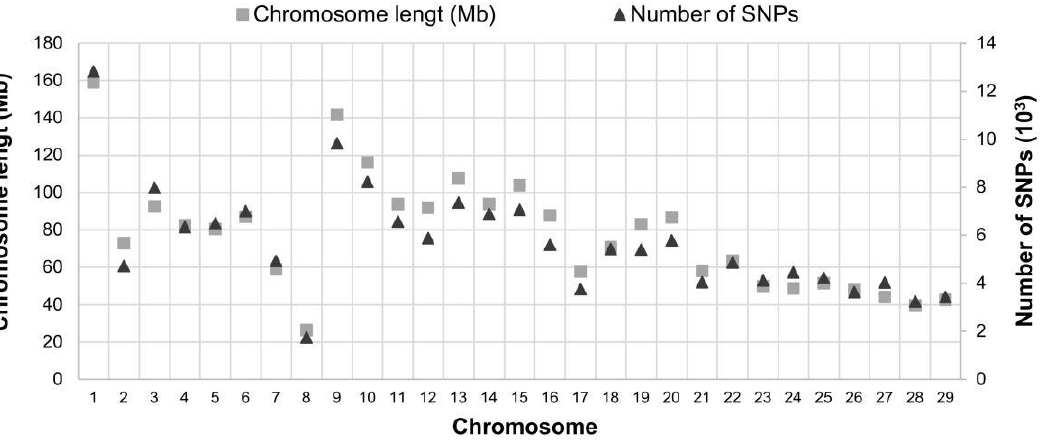
Figure 2. SNP distribution after quality control. A total of 165,774 SNPs remained allocated across the genome and were proportionally distributed according to the size of each chromosome.